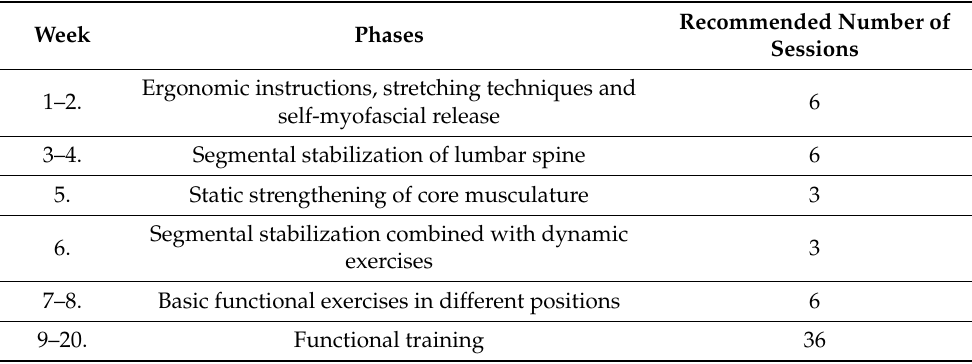
Table 2. Structure of the Training